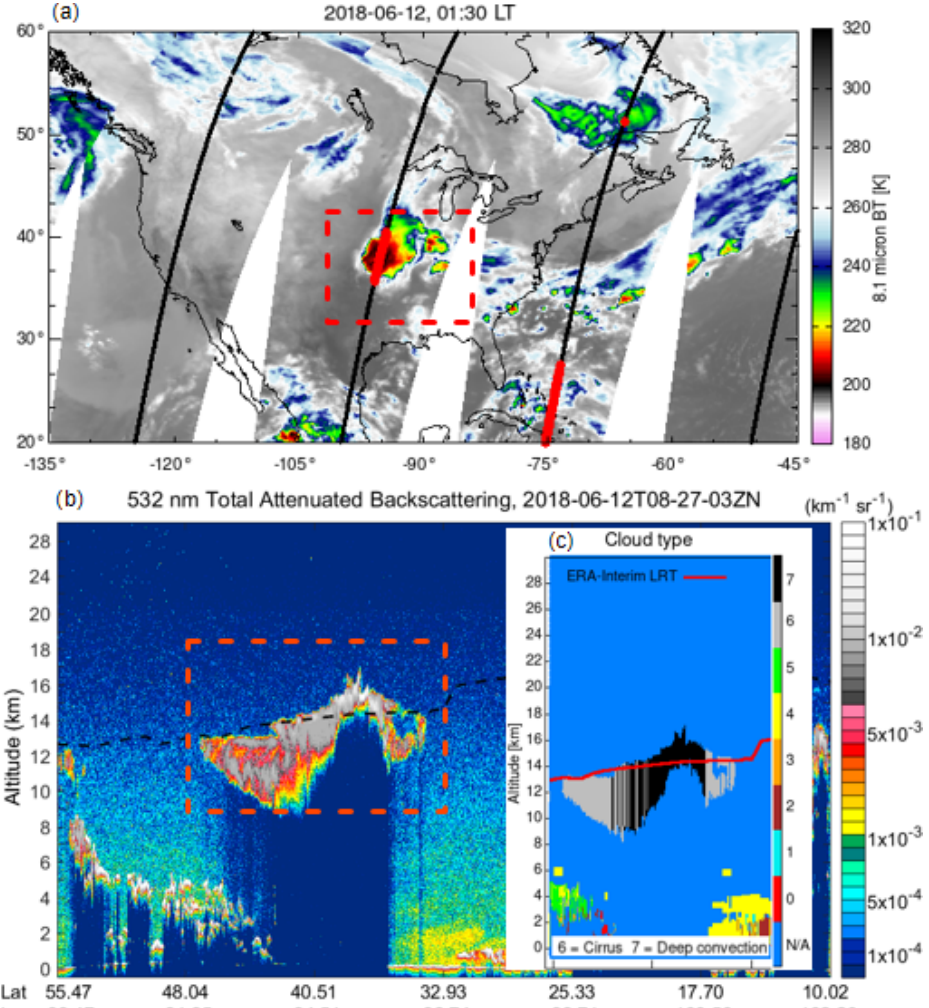
Figure 1. SICs observed above deep convection on 12 June 2018. Panel (a) shows 8.1µm brightness temperatures (BT) derived from AIRS overlaid with CALIPSO orbits (black lines). The red circles along the orbits indicate cirrus with cloud top heights being at least 500m above the tropopause. Panel (b) shows total attenuated backscatter for a whole CALIPSO orbit from (a) ; the region of interest lies within the red dashed region only. The dashed black line indicates the tropopause height derived from ERA-Interim. Panel (c) shows the cloud type from the CALIPSO V4.x Level-2 vertical feature mask data, and the red curve shows the ERA-Interim tropopause